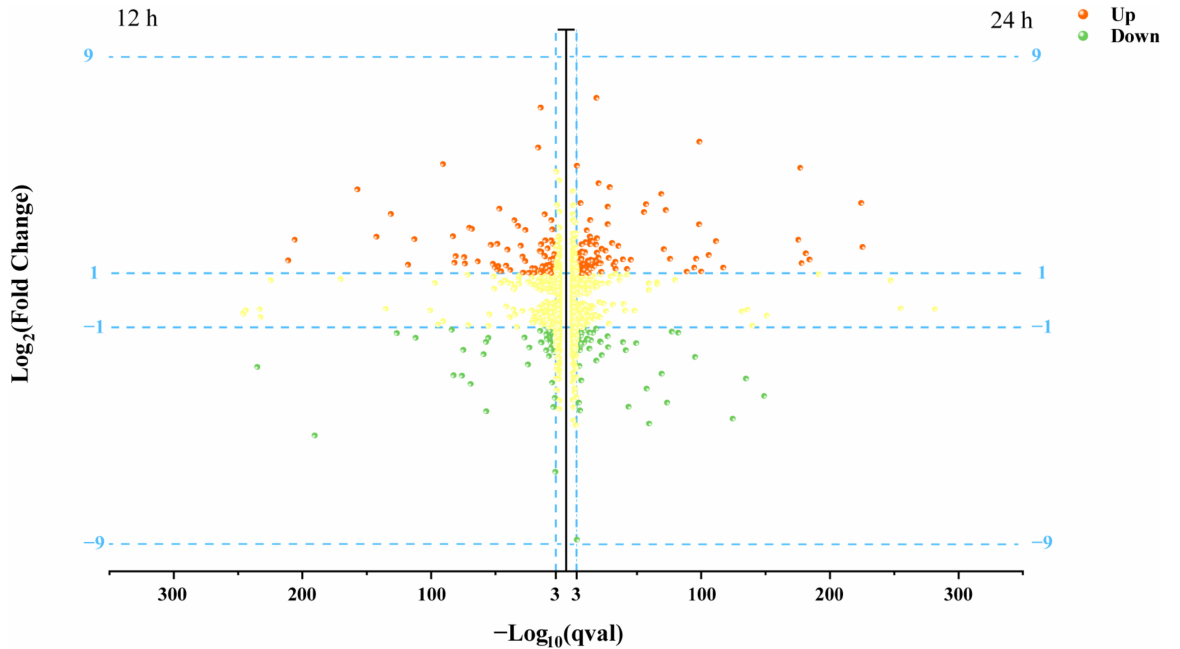
Figure 3. Differential expression genes of P. kudriavzevii C-16 and the type strain ATCC 24210 under 30 g/L lactic acid stress. Imaginary lines indicate inclusion criteria for log 2 (fold change) ≥ 1 or ≤− 1 and − log 10 (qval) > 3. Red, up-regulated expressed genes in P. kudriavzevii C-16; green, down-regulated expressed genes; yellow, genes that did not meet the inclusion criteria.